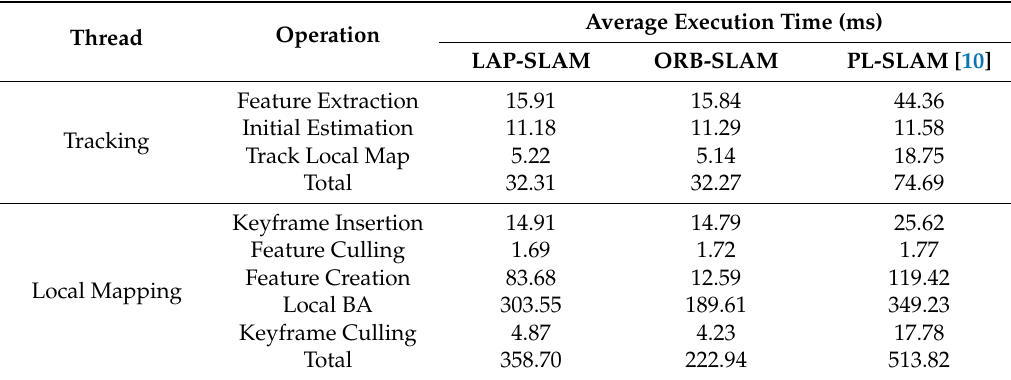
Table 5. Average execution time consumed in tracking and local